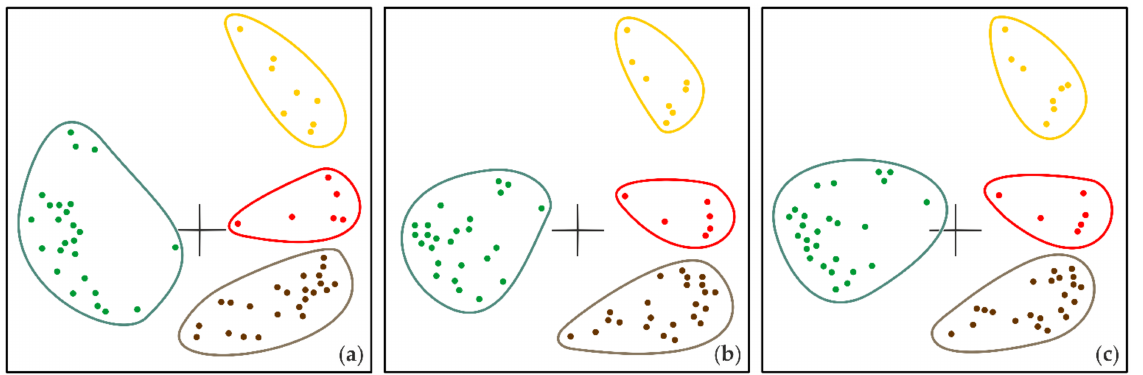
Figure 6. Ordination model of marine benthic communities from Tyrrhenian Sea sedimentary bottoms: ( a ) 147 invertebrate taxa; ( b ) 76 mollusc species; ( c ) 50 conspicuous (>3 mm) and easily identifiable mollusc species. Molluscs are “efficient descriptors”, as the loss of information with respect to the whole community is negligible. Dots represent sampling stations, clustered according to sediment grain size and depth: mud at 20–75 m (green); muddy sand at 10–20 m (brown); sand at 5–10 m (red); fine sand at 3–4 m (yellow). Redrawn and modified from